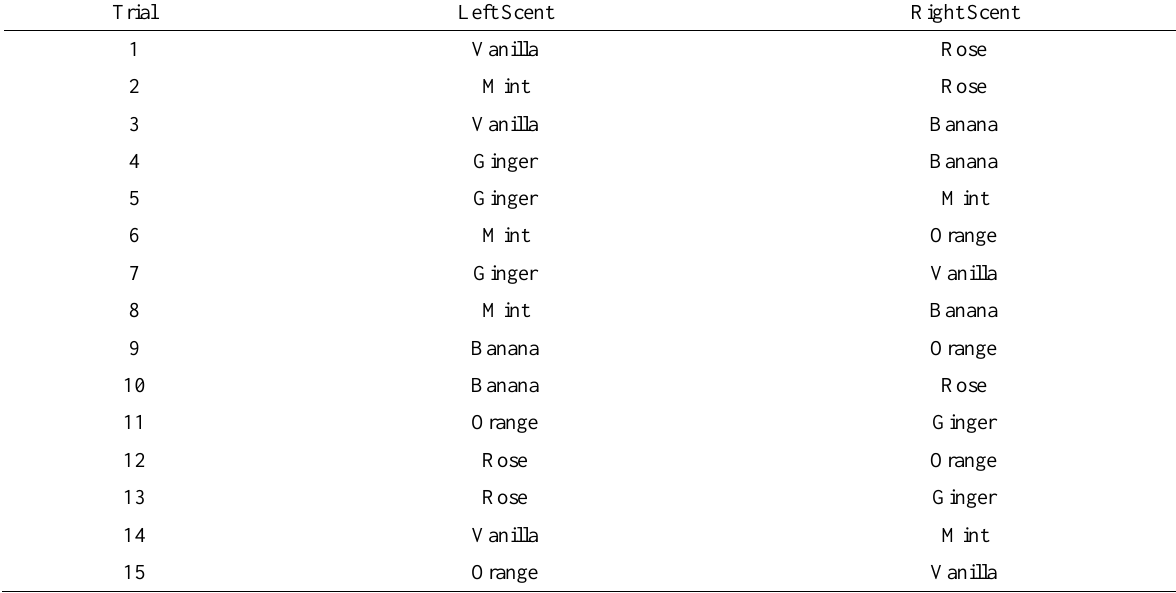
Randomized Scent Distribution for Preference Assessment